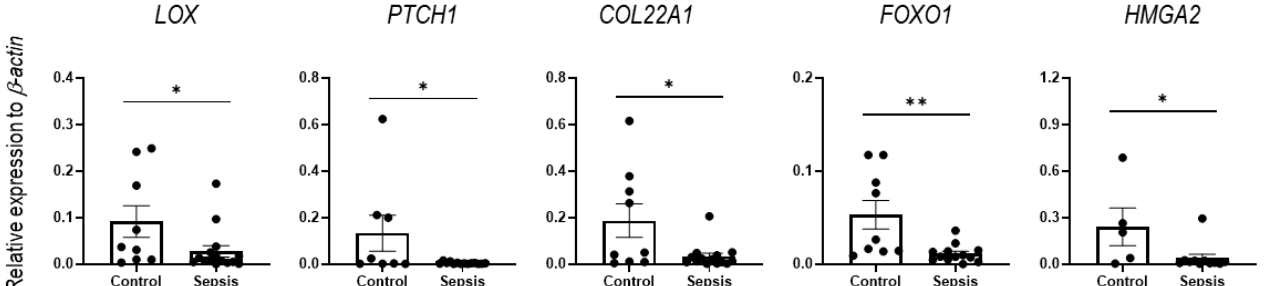
Figure 8. Reduced expression of target mRNAs in sepsis IECs. The expression of the mRNAs of putative targets ( LOX , PTCH1 , COL22A1 , FOXO1 , and HMGA2 ) was analyzed by using RT-qPCR analysis with RNA extracted from the IECs of sham and sepsis mice. β -actin was used as an endogenous control to normalize mRNA expression levels. Data are shown as scatter plots and bars overlaid with the mean ± standard error of the mean (SEM). Dot on the plot represents the value of each mouse. Control and sepsis indicate the IECs isolated from sham and sepsis cohorts, respectively. * p < 0.05 and ** p < 0.01.